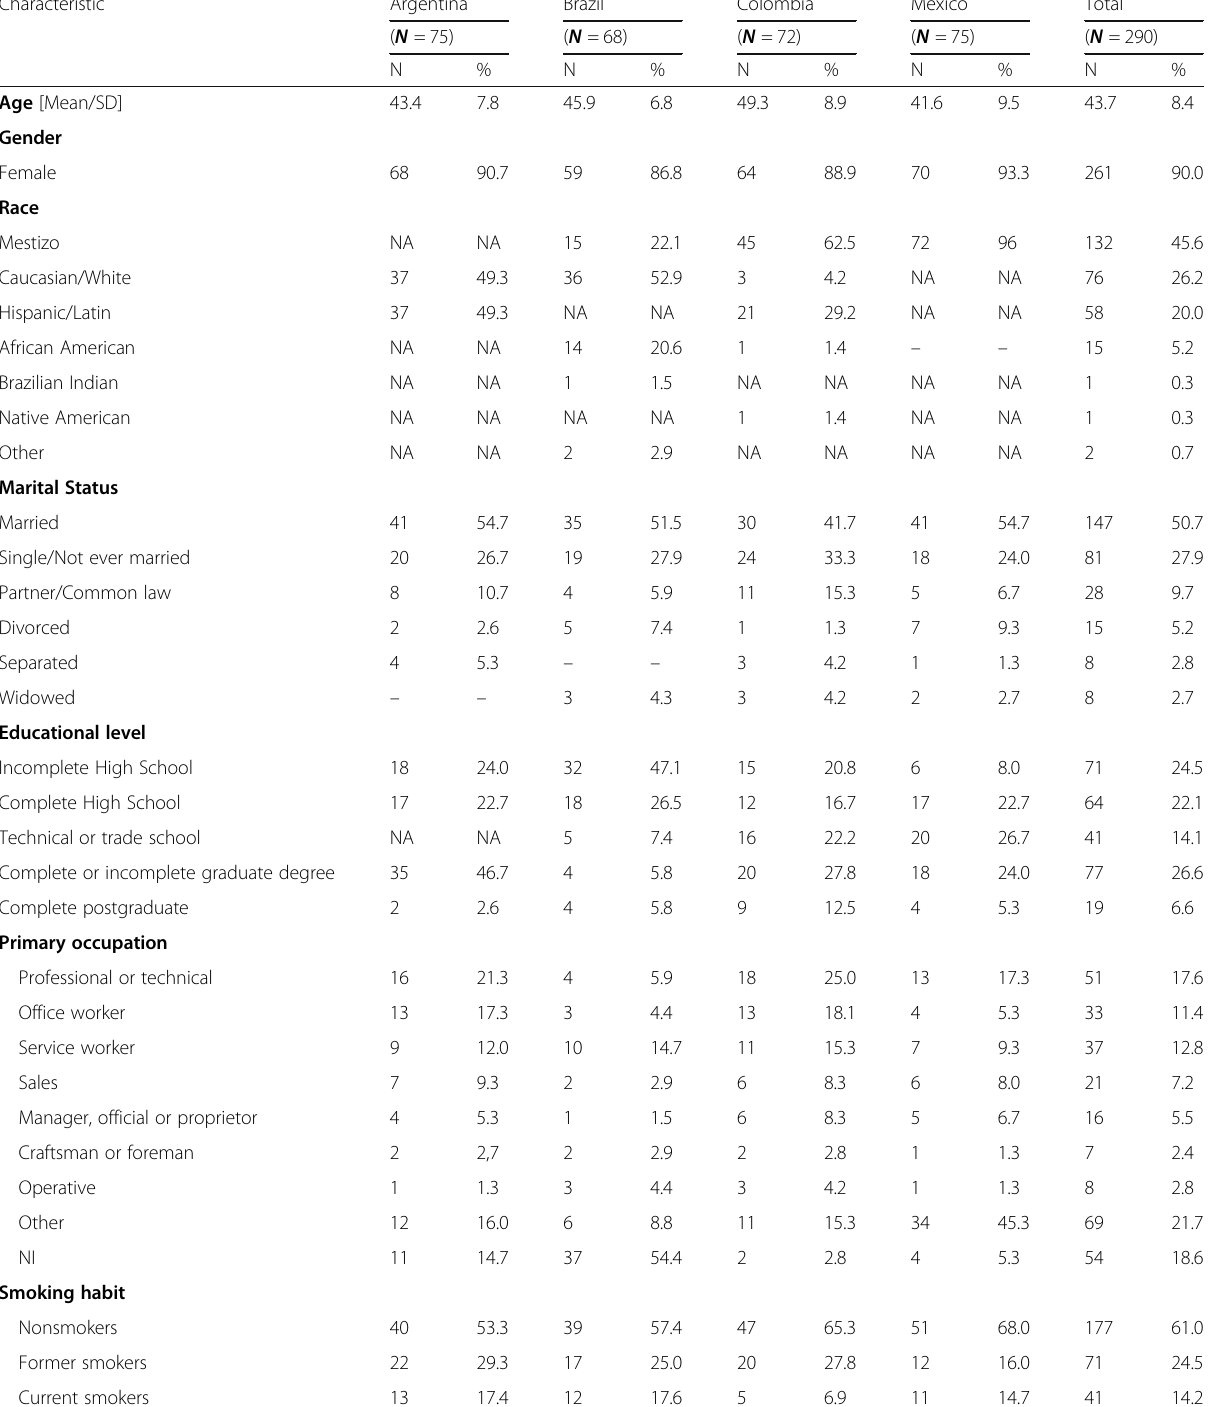
Table 1 Description of studied sociodemographic characteristics among RA patients at baseline